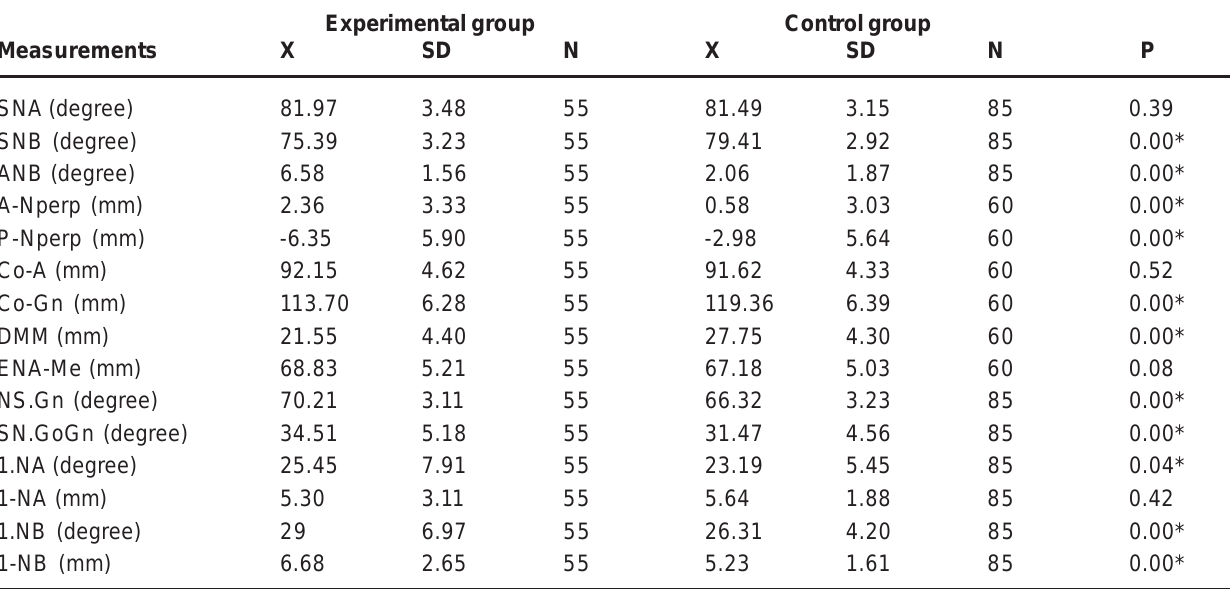
* STATISTICALLY SIGNIFICANT FOR